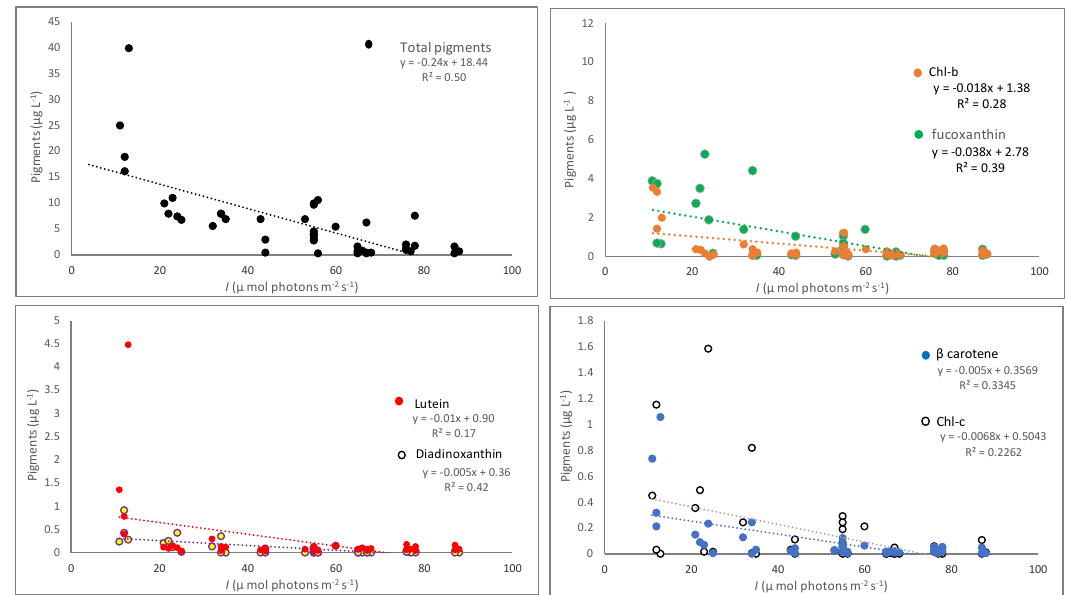
Figure 5. Linear regression analysis between mean underwater light (Irradiance— I ) and combined pigments of all bays studied.